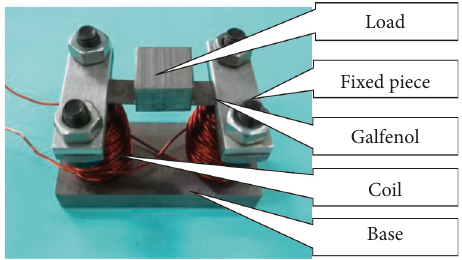
Figure 1: Galfenol-actuated nanopositioning